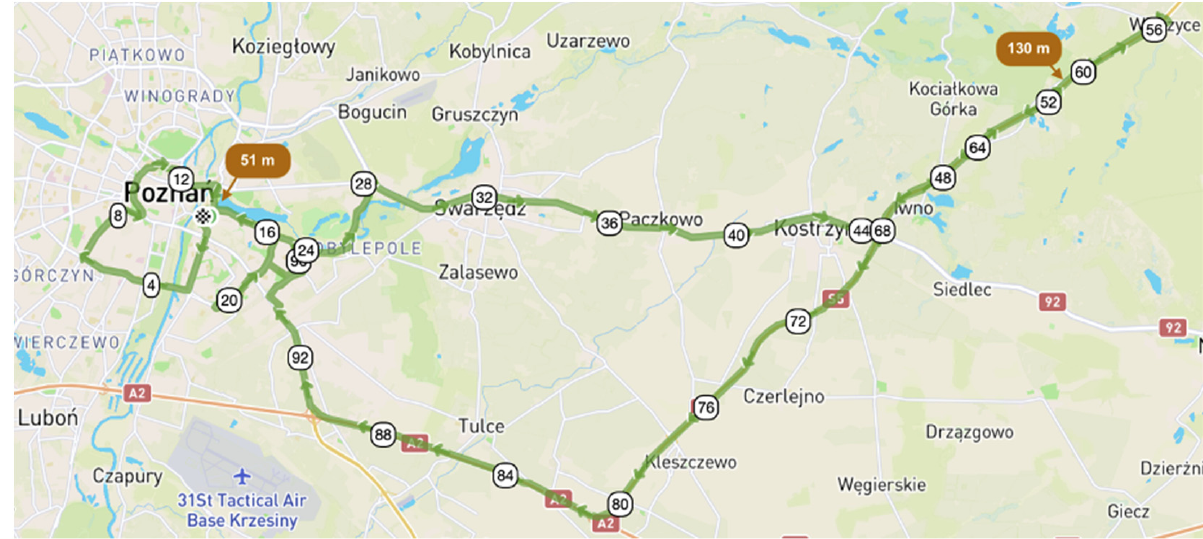
Figure 11. Route driven during the examinations.